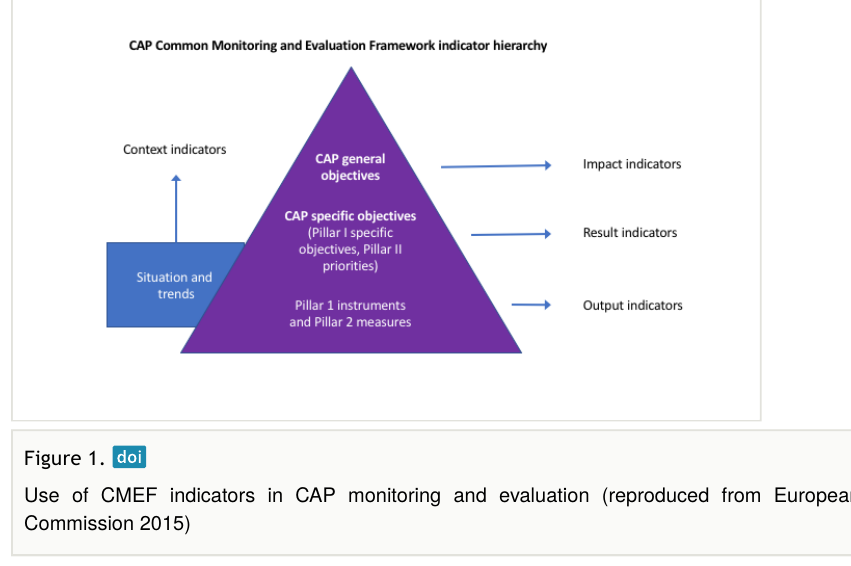
Biodiversity data needs for targeting RDP measures at biodiversity conservation